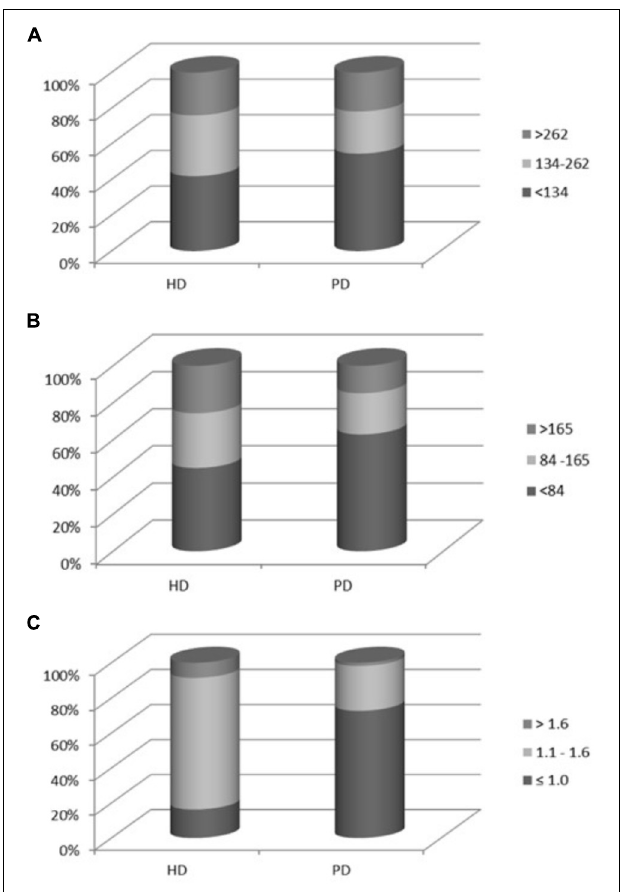
FIGURE 2 | Diagnosis of bone turnover in dialysis according to: (A) KDOQI recommended cut-off levels for iPTH Scantibodies assay normalized according to Soubervielle to obtain the equivalent Allegro iPTH values. [ HTBD : iPTH Scantibodies > 262 pg/ml = Allegro iPTH > 300 pg/ml; NORMAL : iPTH Scantibodies 134–262 pg/ml = Allegro iPTH 300-150 pg/ml; LTBD : iPTH Scantibodies < 134 pg/ml = Allegro iPTH < 150 pg/ml ] . (B) Whole 1-84 PTH assay normalized according to Soubervielle to obtain the equivalent Allegro iPTH values. [ HTBD : whole 1-84 PTH > 165 pg/ml =